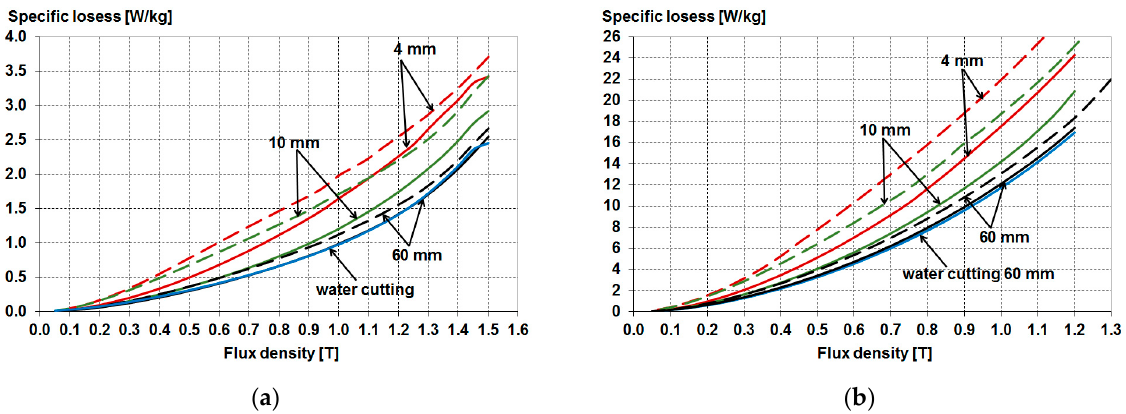
Figure 27. Measured at 50 Hz ( a ) and 300 Hz ( b ) loss characteristics of the M270-35A sheet for various widths of sheet samples cut with a guillotine (solid line) and laser cut samples (dashed line).